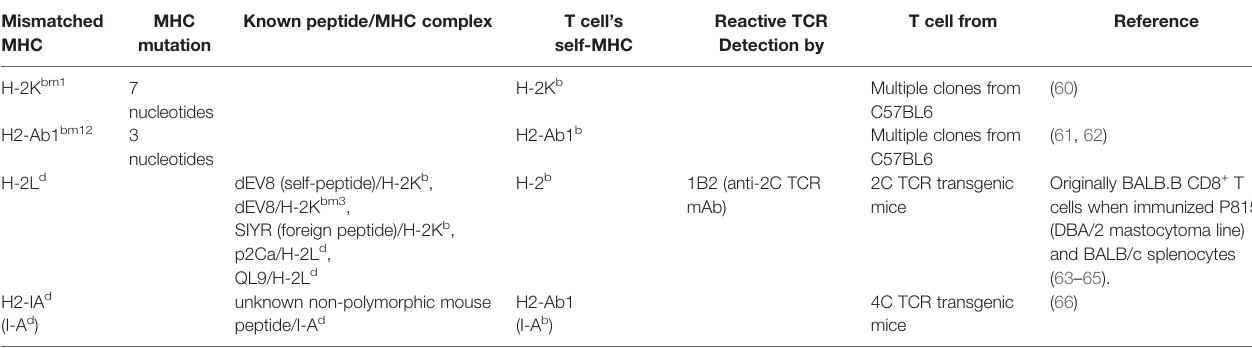
TABLE 2 | Antigen presentation within mismatched MHC. miHA